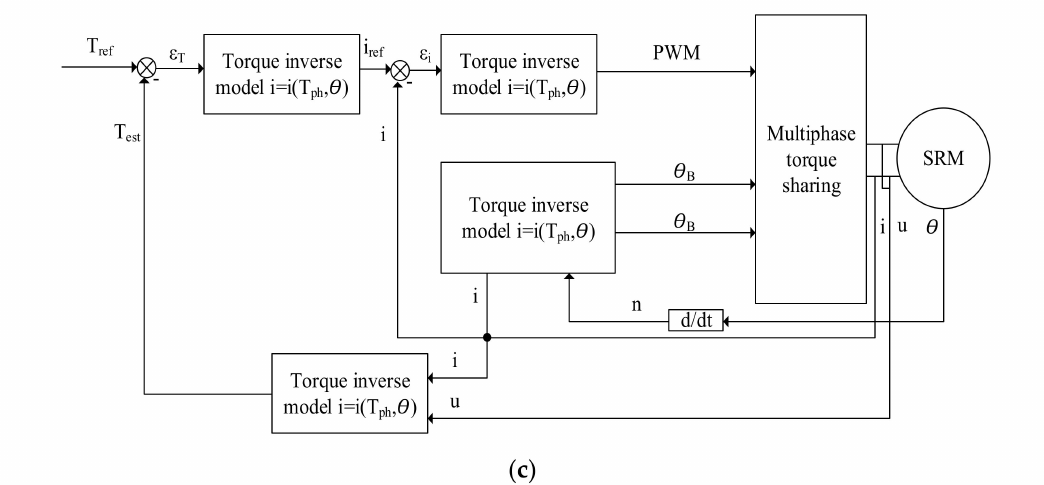
Figure 18. Block diagrams of torque control schemes: ( a ) PWM-DITC edited from [104]; ( b ) DITC [105]; ( c ) ATC [106].